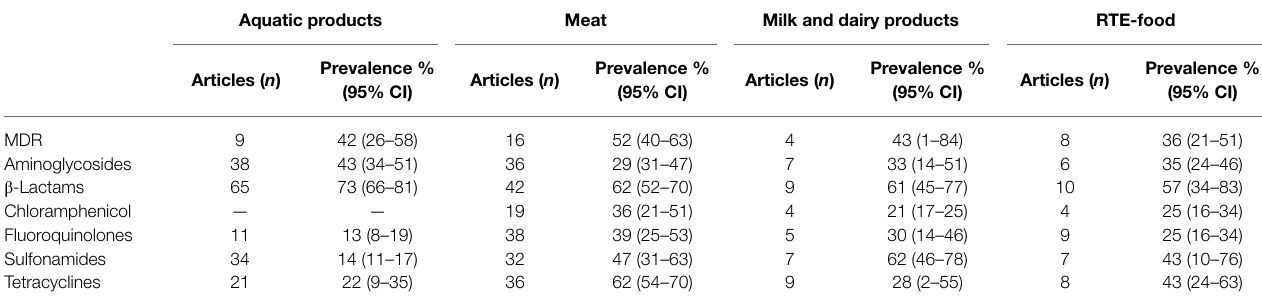
TABLE 3 | Subgroup analysis of antibiotic resistance by food types.